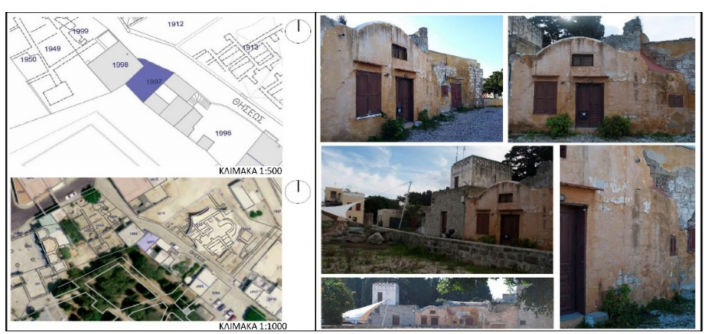
Figure 20. Thiseos 08 (listed building—evaluation sheet).